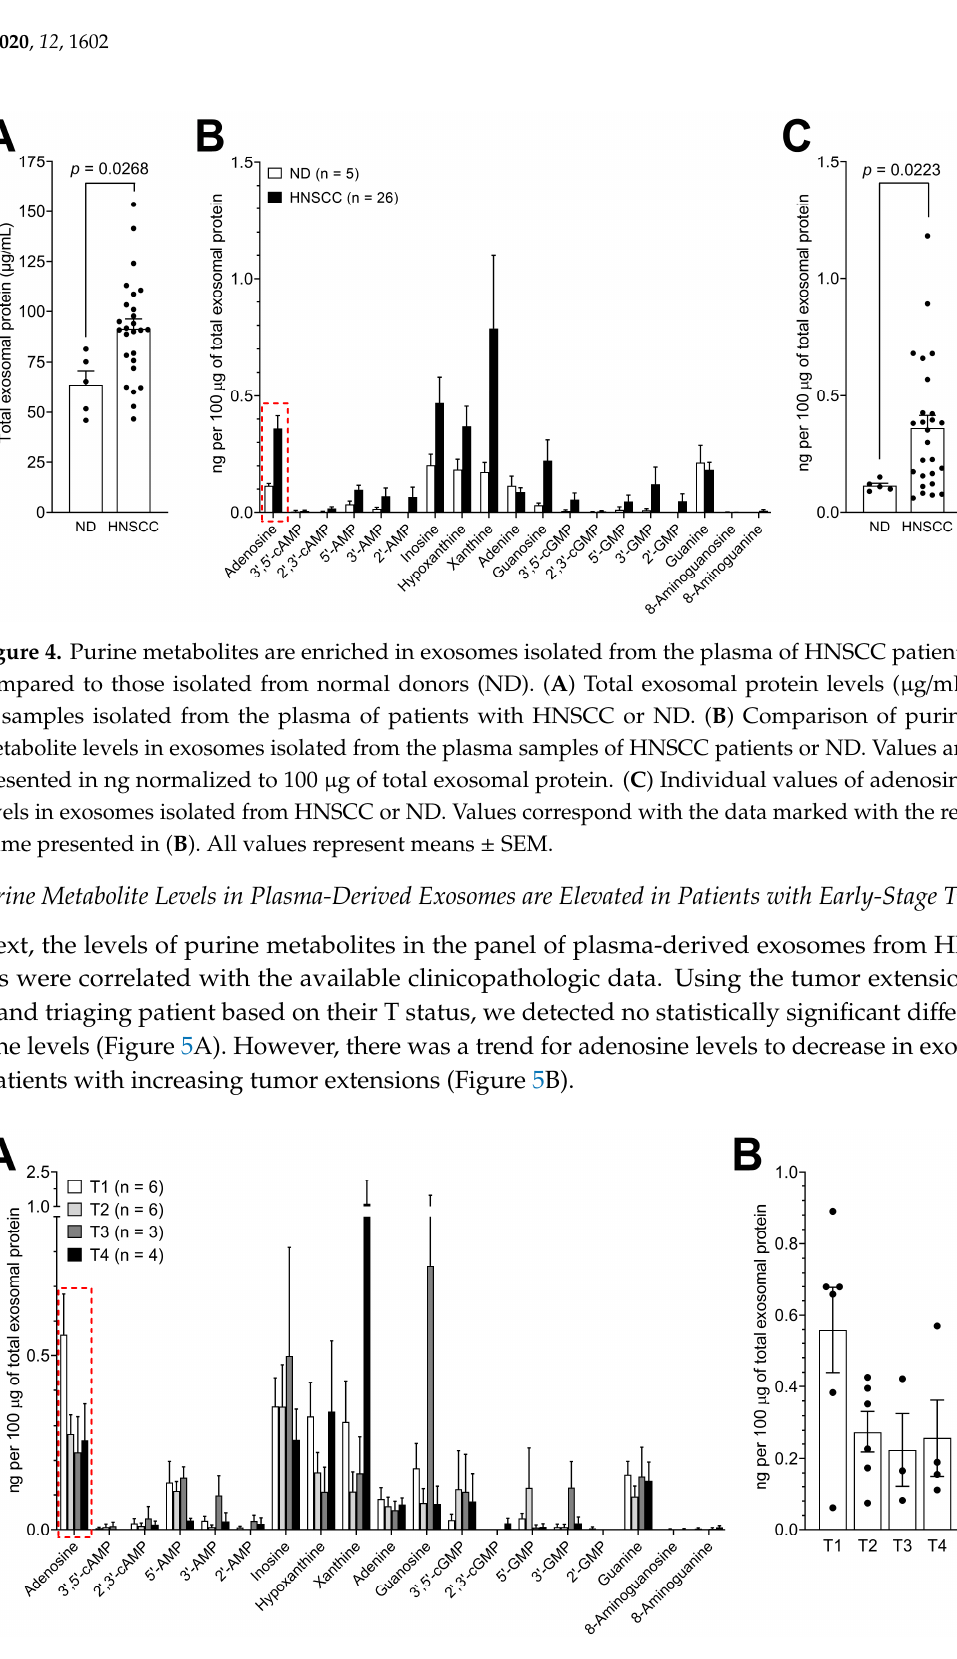
Figure 5. Purine metabolites levels in plasma-derived exosomes of HNSCC patients according to tumor extensions. ( A ) Values presented in Figure 3B were divided based on tumor extensions (T status) as indicated in the legend. ( B ) Individual values of adenosine levels in plasma-derived exosomes from HNSCC patients with indicated tumor extensions (T1-T4). Values correspond with the data marked with the red frame presented in ( A ). All values represent means ± SEM. Patients were then triaged based on their lymph node (LN) involvement status and purine metabolite levels in exosomes. The exosome profiles in patients with ( n = 10) and without ( n = 15) LN metastasis were compared. Interestingly, most purines in the panel showed higher values in patients without LN metastasis, with only a few exceptions (inosine, 3 ′ ,5 ′ -cGMP, guanosine, guanine; Figure 6A). Levels of adenosine were significantly decreased in exosomes of patients with LN metastasis ( p = 0.0247; Figure 6B) as were the exosome levels of 5 ′ -GMP ( p = 0.0229; Figure 6C). In aggregate, circulating exosomes of HNSCC patients with the early disease stage without LN involvement contained high levels of purine metabolites. With the disease progression and appearance of LN metastases, levels of purine metabolites in the panel decreased. Thus, changes in the purine profile of exosomes emerge as potentially useful surrogates of disease progression.